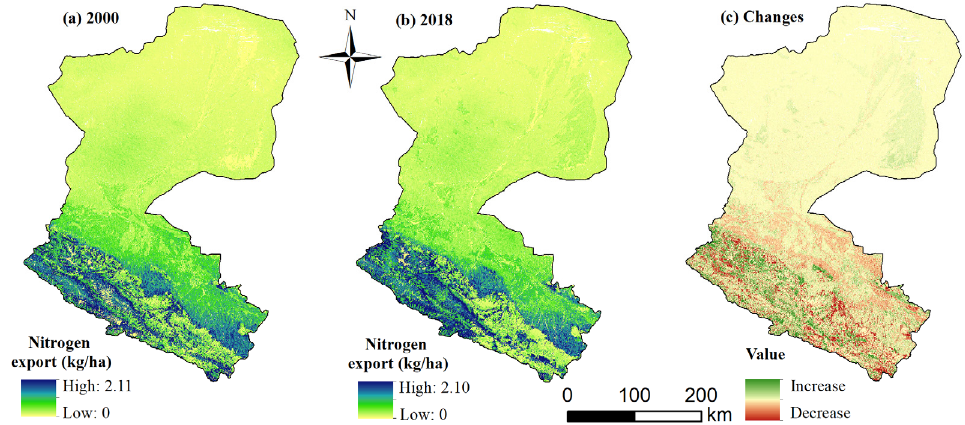
Figure 8. Spatial distribution and changes in nitrogen export from 2000 to 2018 ( a ): nitrogen export in 2000; ( b ): nitrogen export in 2018; ( c ): changes from 2000 to 2018).